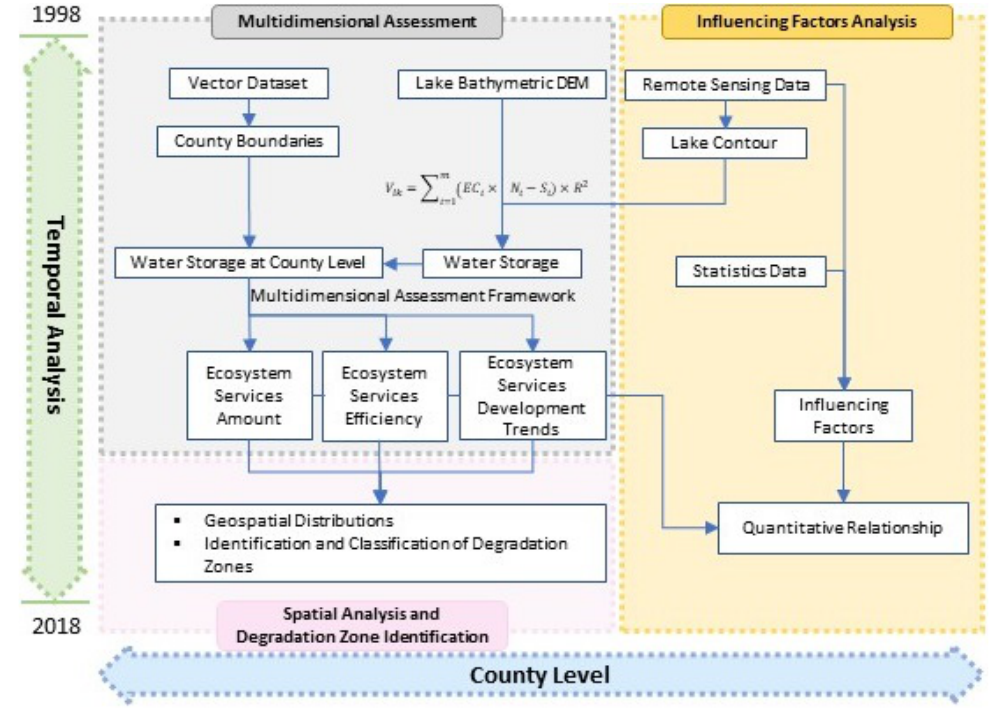
Figure 1. The flowchart of this study.